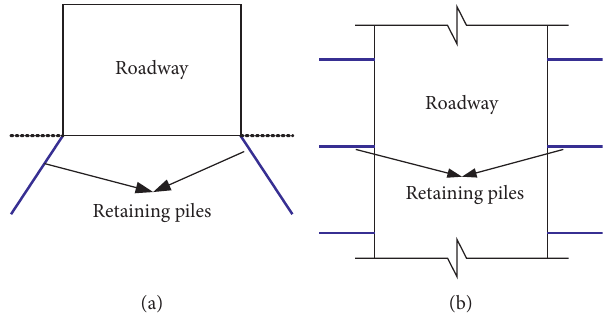
Figure 4: Indication diagram of retaining pile arrangement. (a) Sectional drawing; (b) vertical view.